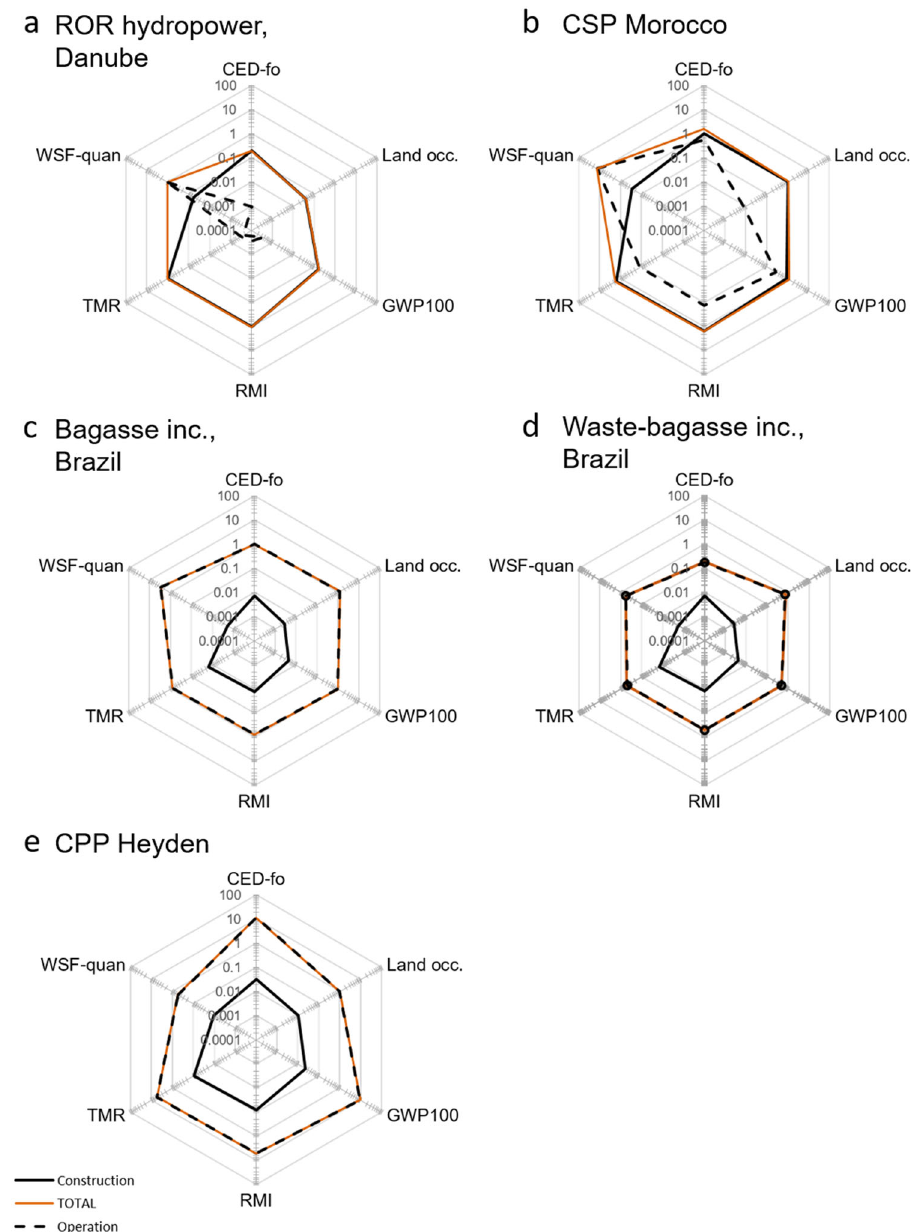
Fig. 3 Environmental pressures of electricity generation systems per case study. Results are presented by case studies for the construction and operation phase a – e on a logarithmic scale per 1 kWh produced electricity, respectively. For each environmental pressure, LCIA results for operation, construction, and total have been normalised by the median total result of all case studies (details Fig. 2). ROR run-of-river, CSP concentrated solar power plant, Bagasse inc. Bagasse incineration, CPP coal- fi red power plant, CED-fo Cumulative Energy Demand, fossil, Land occ. Land occupation, GWP100 Global Warming Impact, RMI Raw Material Input and TMR Total Material Requirement and WSF-quan Quantitative Water Scarcity